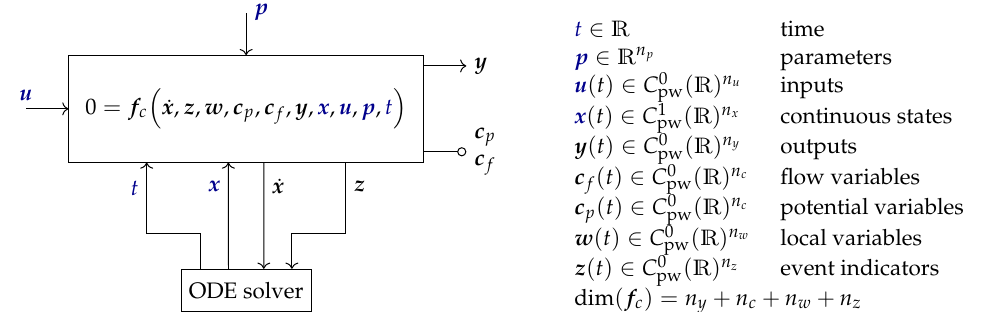
Figure 1. Mathematical description of an acausal component. Components can be connected via u , y , c p , c f . Events are defined by zero crossings of elements of z . At events, variable values can change discontinuously. R is the set of real numbers. C k pw ( R ) n is the space of piecewise (pw) k -times continuously differentiable functions in n dimensions. 0 = f c ( . . . ) is a set of implicit equations. Variables in dark blue are assumed to be known: variables t , x are provided by the ODE solver, p are parameters that get constant values before simulation starts, u are inputs and are provided externally to the component. There are n c equations missing in order to solve 0 = f c ( . . . ) for its unknowns ˙ x , z , w , c p , c f , y . These missing equations are provided when connecting the component via the connection equations of c p , c f